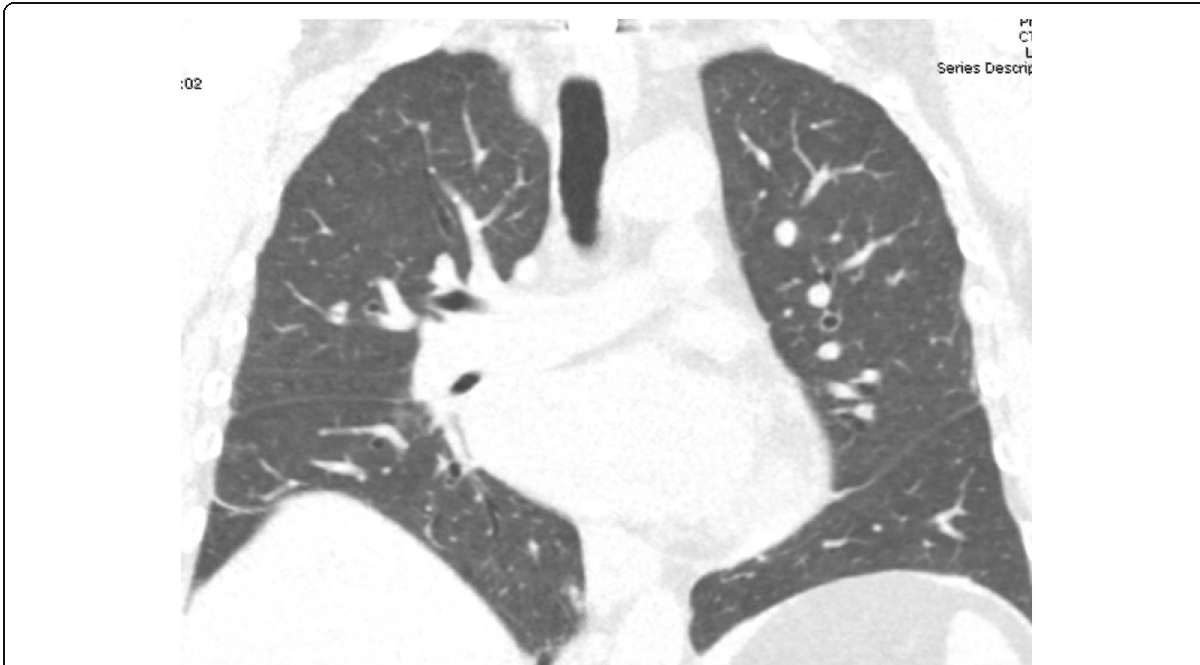
Fig. 2 Coronal CT reformatted image of the chest during the admission for the recent viral infection (before Covid) shows clear lungs without any cysts and no evidence of